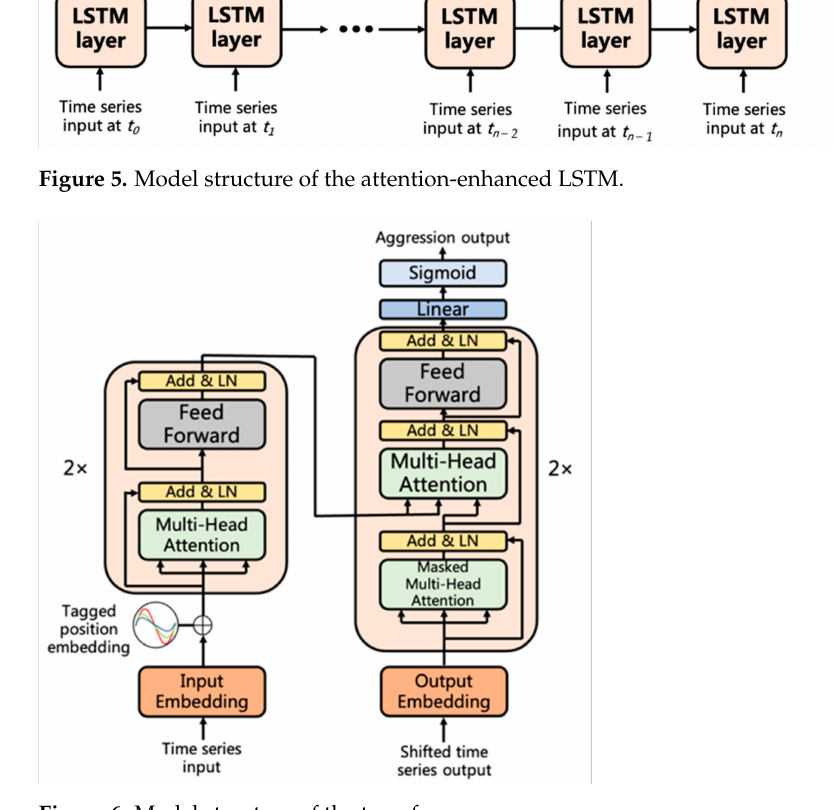
Figure 6. Model structure of the